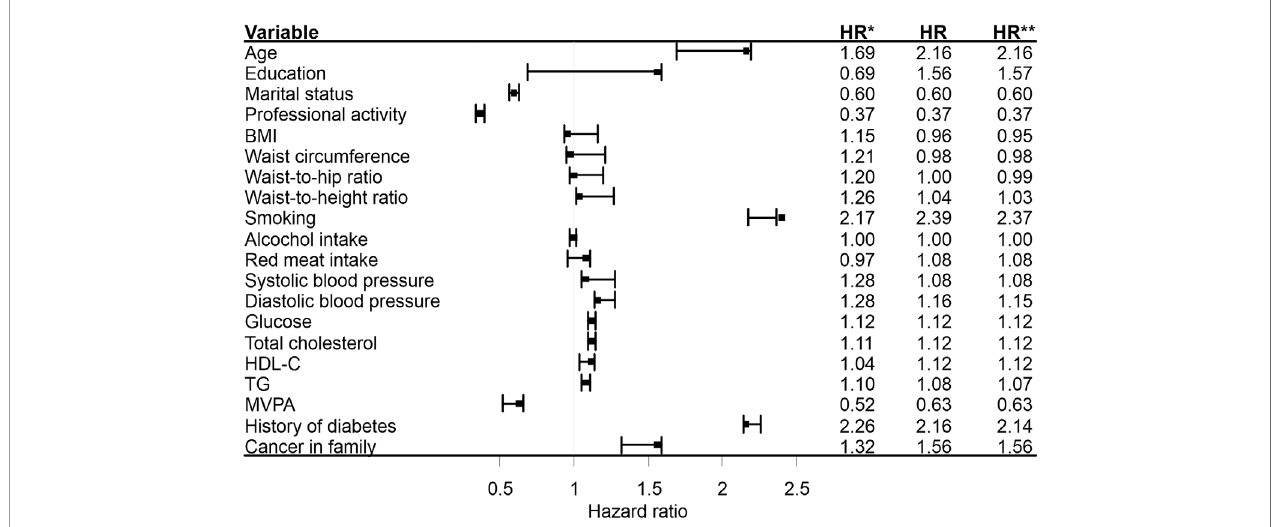
FIGURE 1 | Sensitivity analysis based on the unadjusted, cause-speci fi c hazard models. HR*, hazard ratios based on the extremal model 1(cancer death and non- cancer death were treated equally and modeling simultaneously); HR, hazard ratios based on the study model(cancer death was treated as an event, non-cancer death was treated as censored observation); HR**, hazard ratios based on the extremal model 2 (cancer death was treated as an event, individuals in whom the non-cancer death occurred were attributed the longest duration observed in the group and treated as censored observations). BMI, body mass index; HDL-C, high density lipoprotein cholesterol; TG, triglyceride; MVPA, moderate to vigorous physical activity in